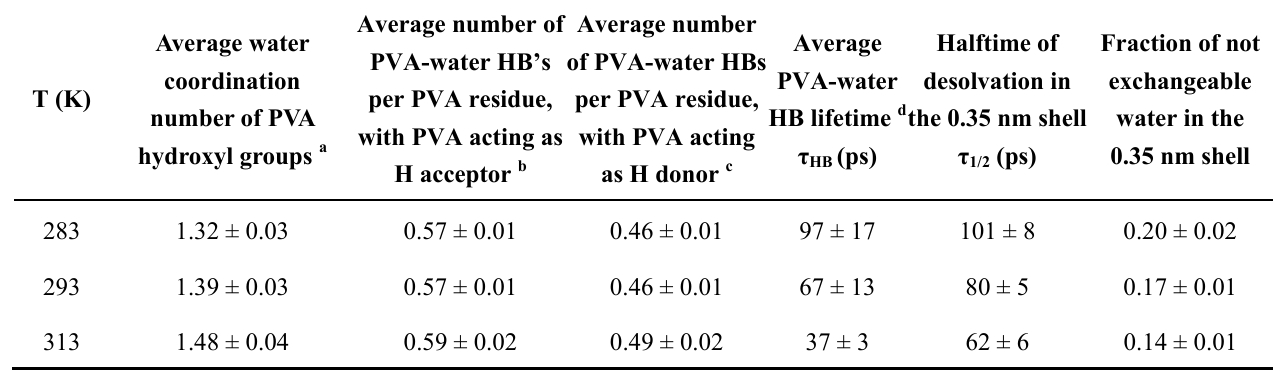
Table 3. PVA-water interaction: hydrogen bonding and water dynamics in the first hydration shell.